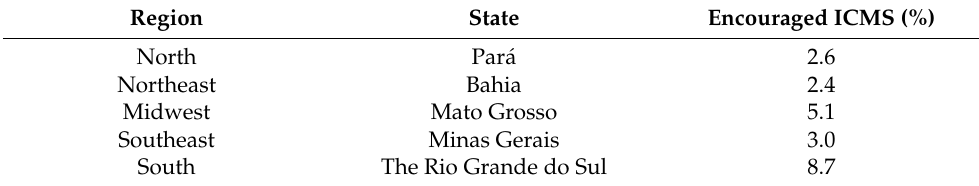
Table 15. Encouraged ICMS for five states in